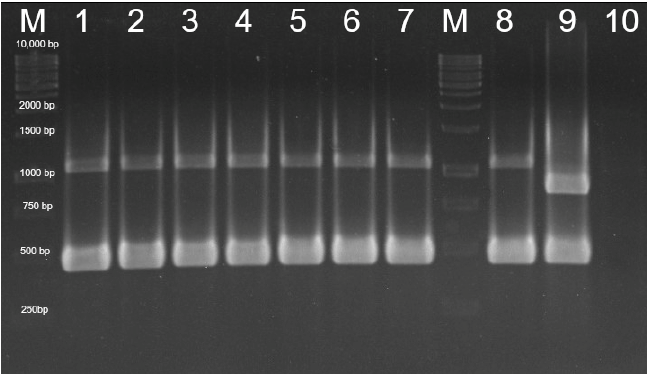
Figure 5. Identification of P. multocida type A by PCR: M: Marker (O’ Gene Ruler 1kb DNA Ladder,